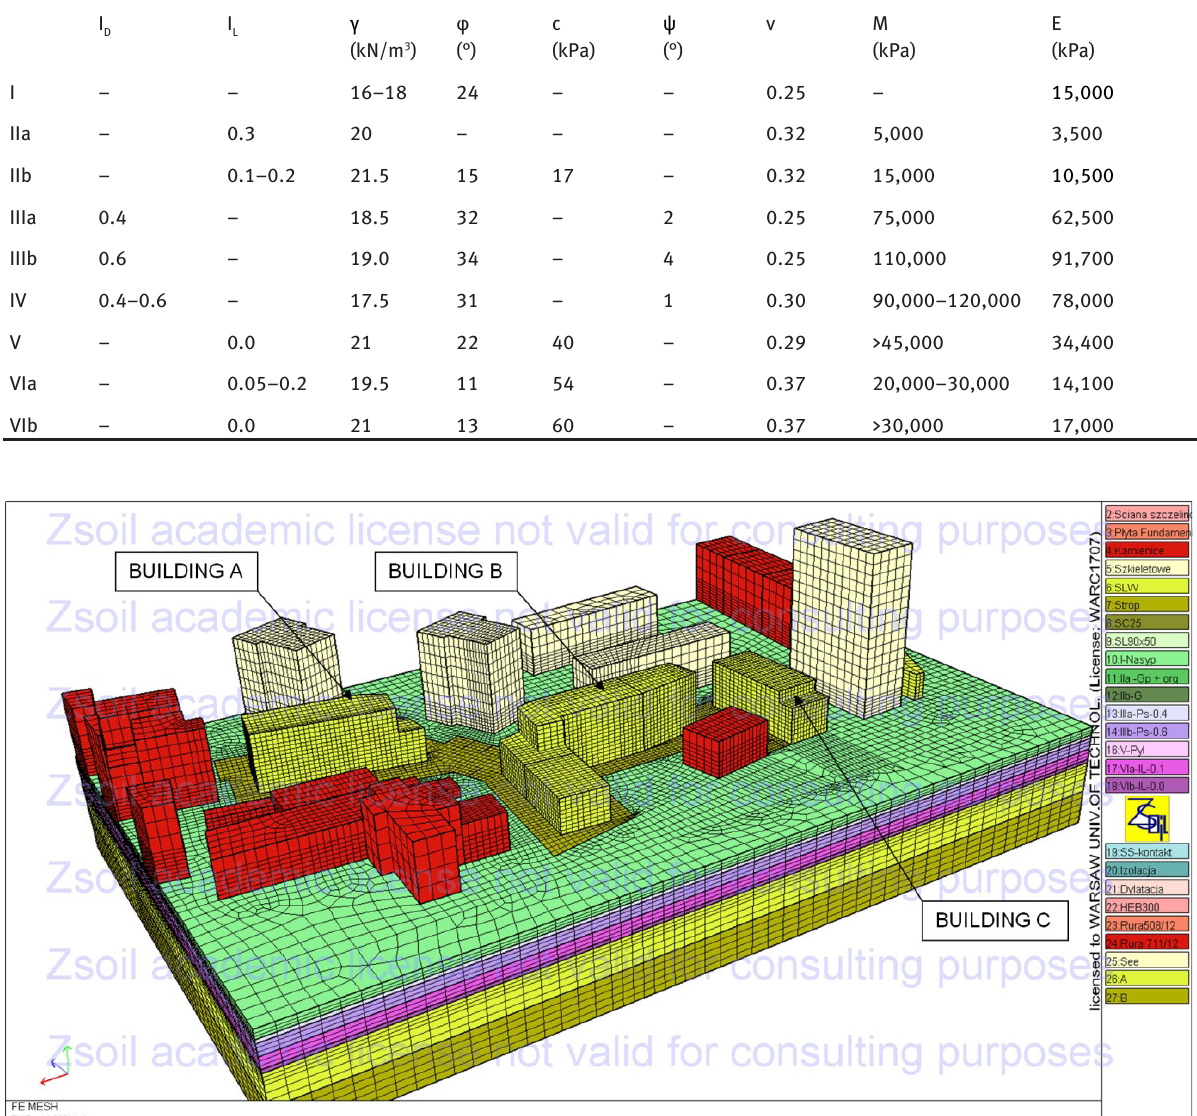
Table 1: Subsoil parameters adopted in the model of the subsoil on the basis of the documentation [34]. Layer No